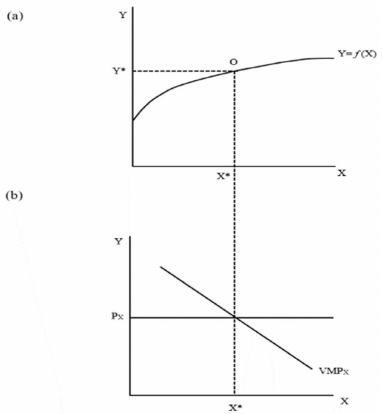
Figure 1. Optimal Input Use and Output Production for Profit. ( a ) A Typical Production Function in Agriculture. ( b ) Optimal Input Decision in the Production